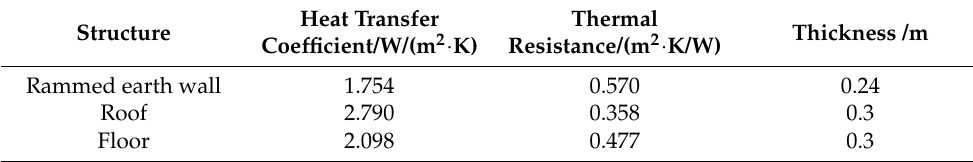
Table 3. Parameters of the packaged terminal heat pump system.